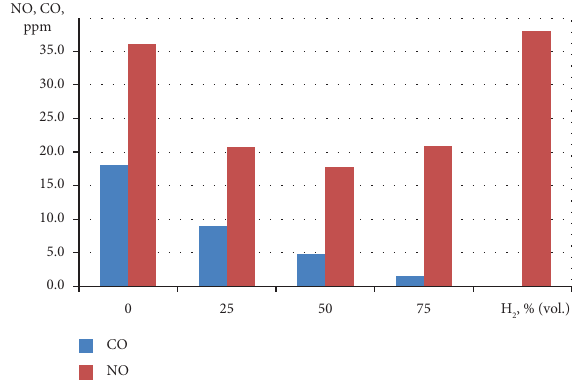
Figure 12: Distribution of mole fractions of NO and CO at the fame tube outlet for diferent volume content of hydrogen in the mixture.